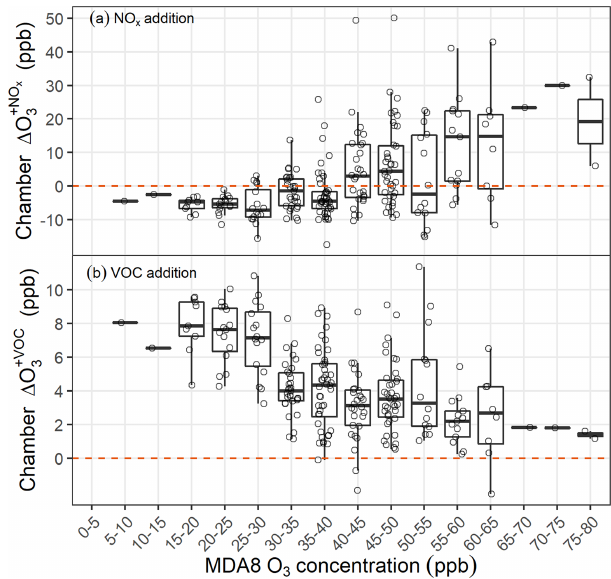
Figure 6. Boxplot of O 3 sensitivity to NO x and VOC as a function of MDA8 O 3 concentration. Points indicate the data point in each range of MDA8 O 3